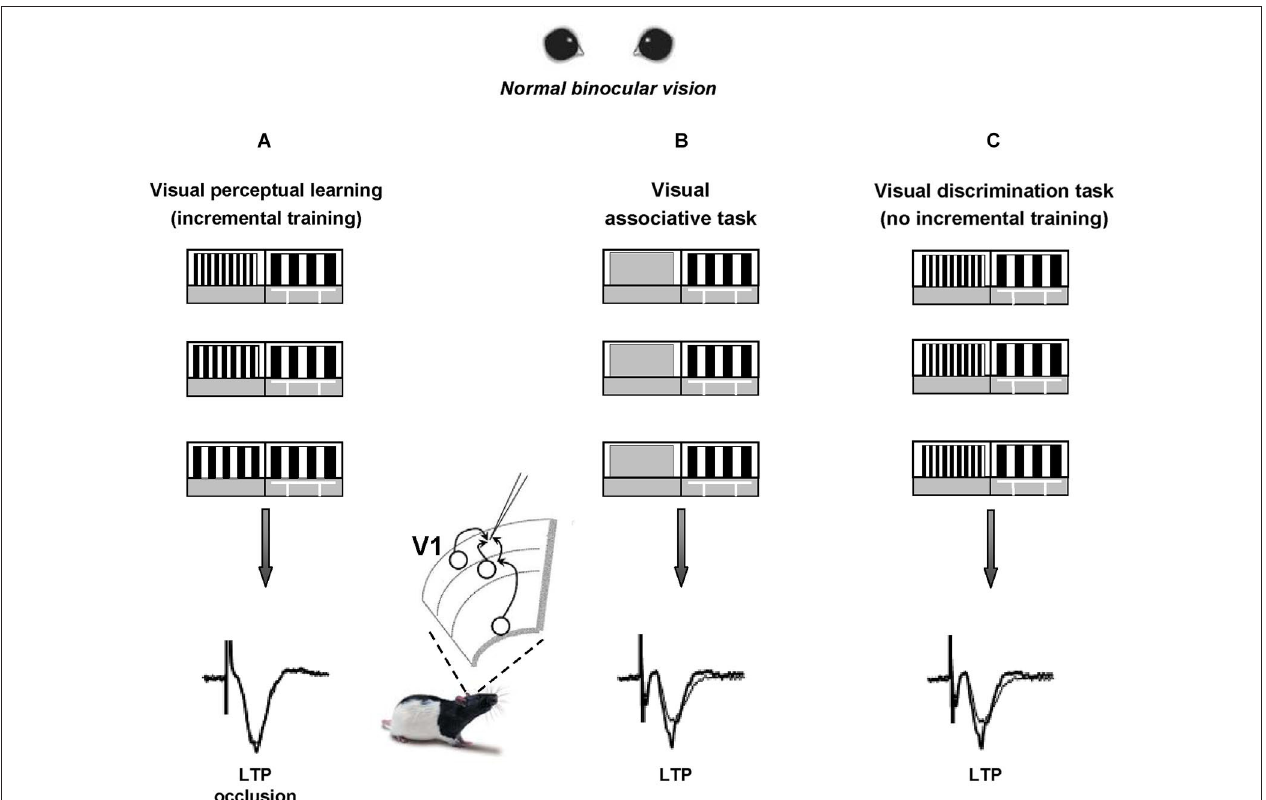
when they became more and more similar to each other. Two groups of control animals are trained to either distinguish the reference grating from a homogeneous gray ( panel B ) or to distinguish a low SF vs. a never changing high SF panel ( panel C , thus lacking the incremental training). After training, LTP from layer II-III of V1 slices is occluded in PL animals compared to controls, at the level of both vertical and horizontal